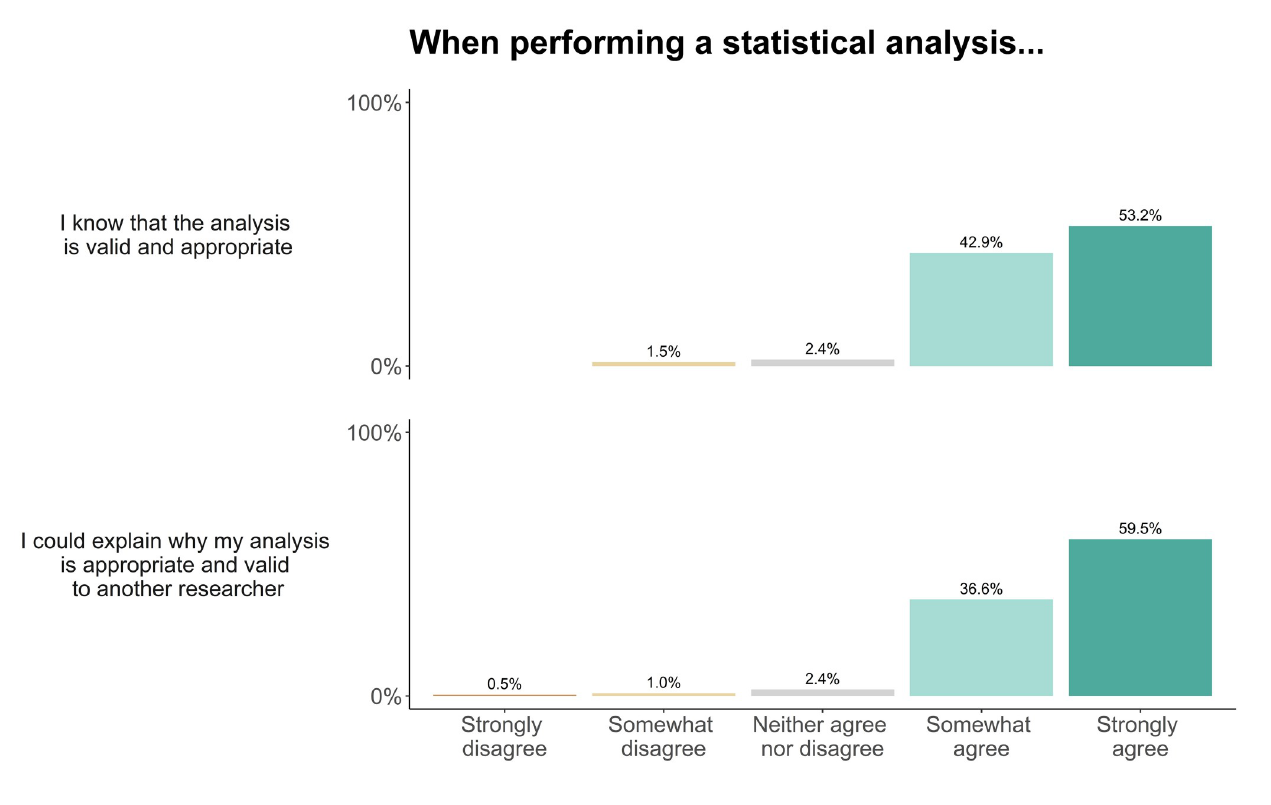
Fig 11. Animal cognition researchers’ self-reported confidence in their own statistical analyses, N =